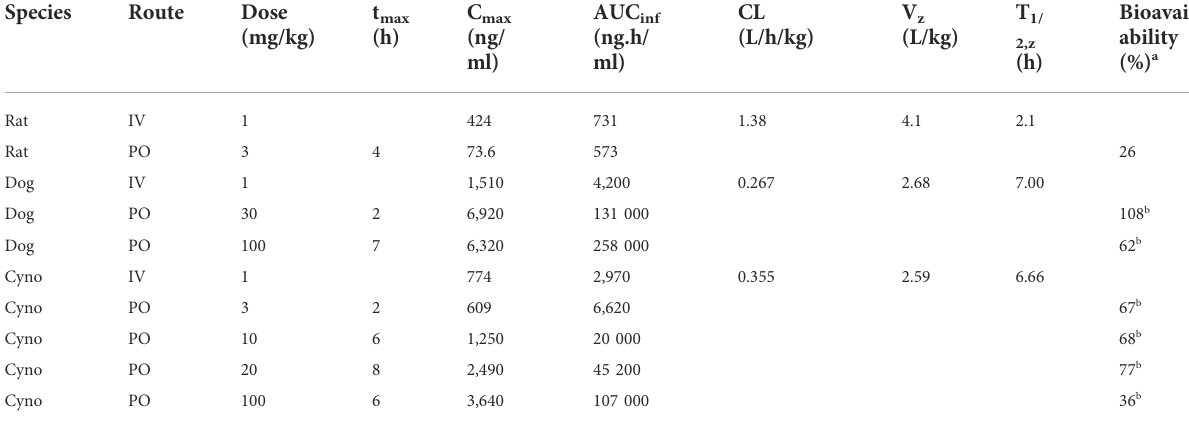
TABLE 5 Pharmacokinetic parameters following single administration to male animals.